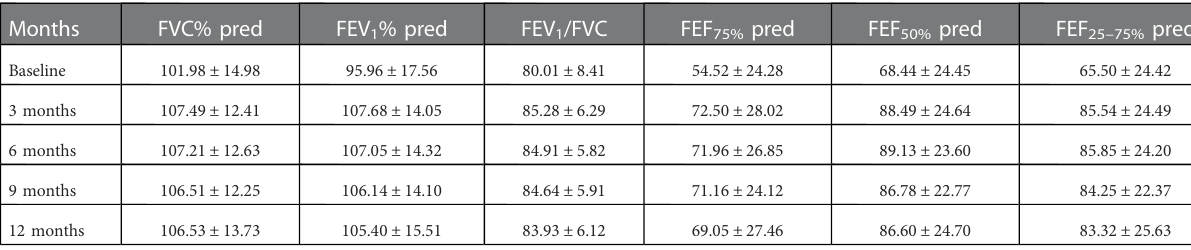
TABLE 3 Spirometry parameters over